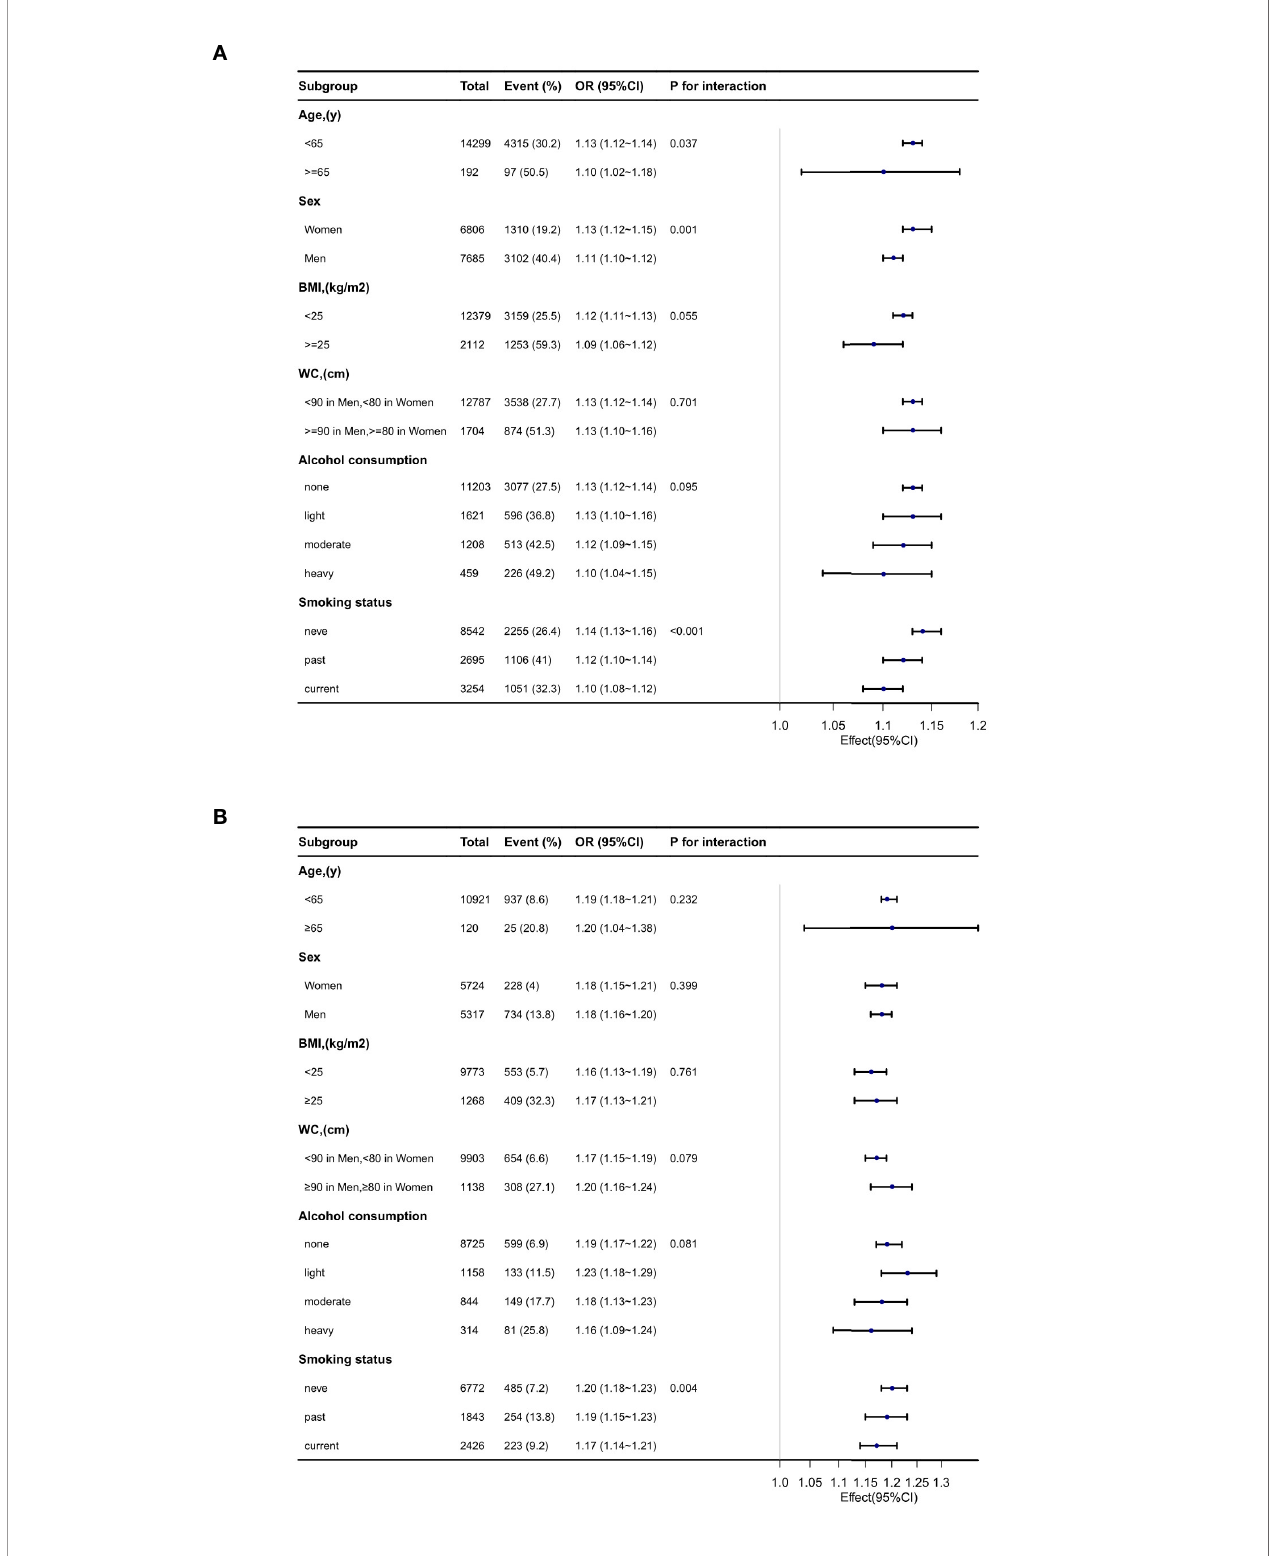
FIGURE 3 | Subgroup analyses of the METS-IR and prehypertension (A) and hypertension (B)